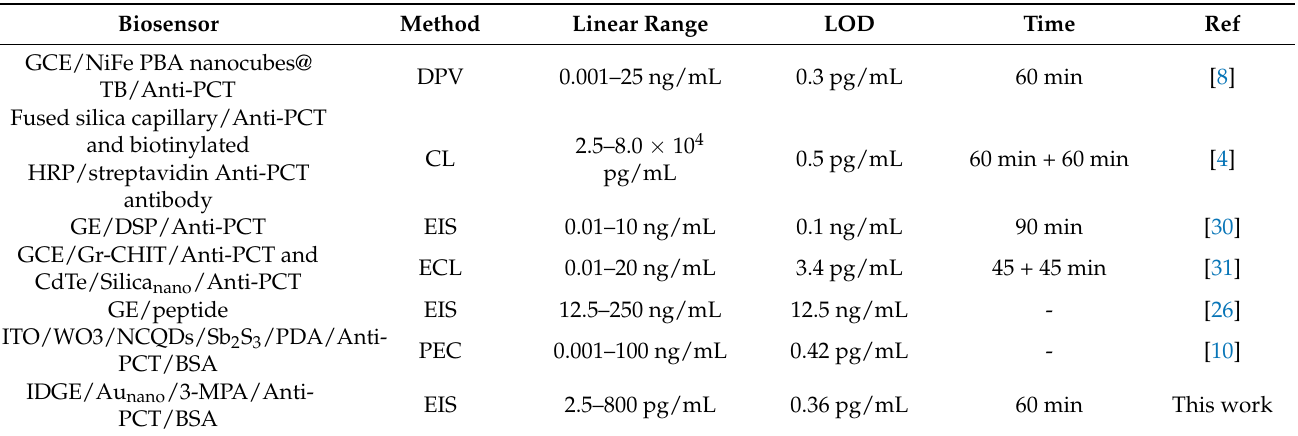
Table 1. Comparison of the analytical performance of the IDGE/Au nano /3-MPA/Anti-PCT/BSA with some of the biosensors for PCT